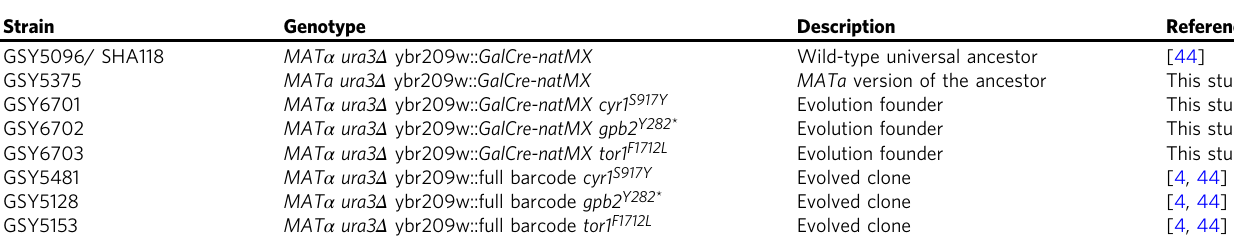
Table 1 Strains used in this